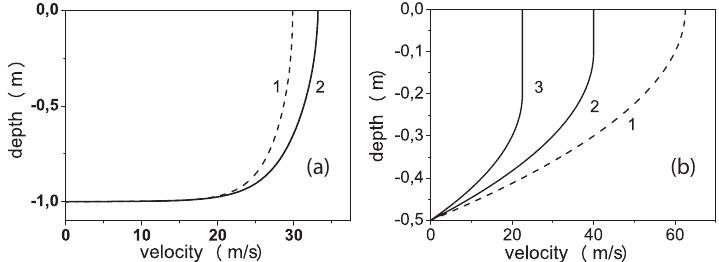
Figure 17. ( a ) Velocity profiles in turbulent stationary flows for τ y / ρ = 0 and 0.2 m 2 /s 2 (curves 1, 2, respectively). ( b ) Velocity profiles in laminar stationary flows for τ y / ρ = 0; 0.5; 1 m 2 /s 2 (curves 1, 2, 3,